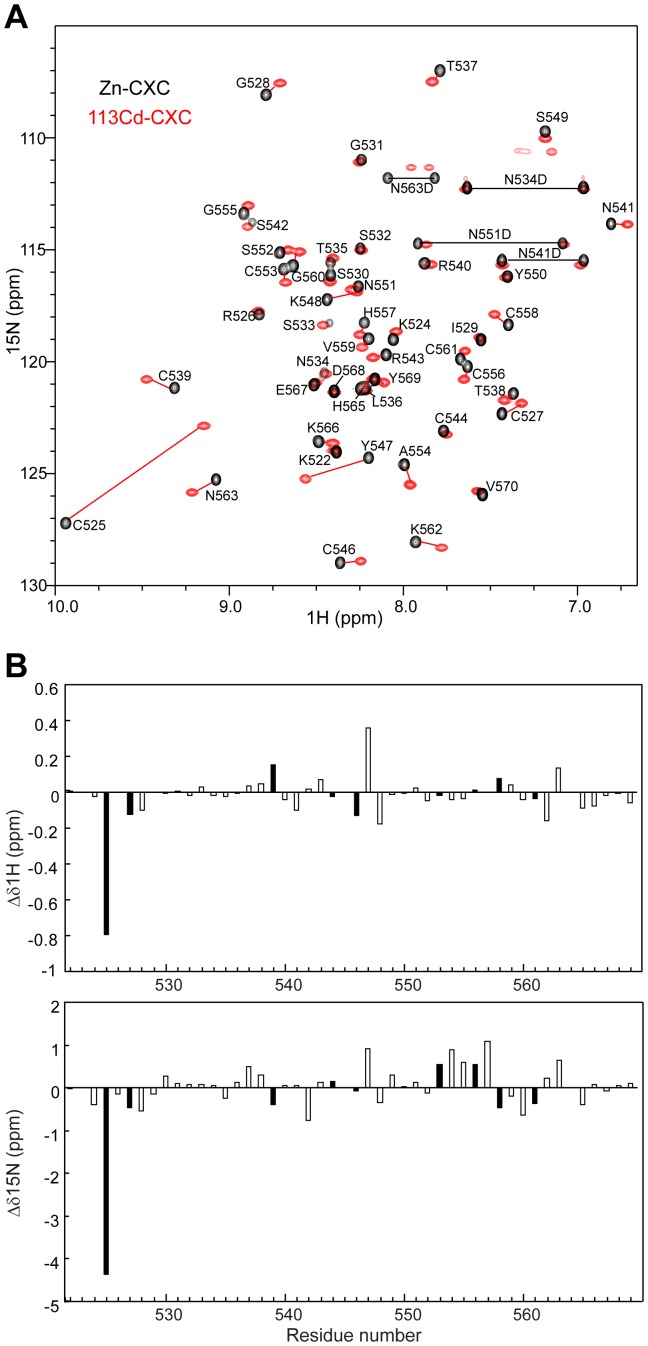
Chemical shift perturbation by 113Cd substitution.(A) Superimposed 1H-15N HSQC spectra of Zn-loaded (black) and 113Cd-loaded (red) CXC-3 proteins. Assignments are indicated for Zn-CXC. The distantly separated peak pairs are connected by red lines. The 113Cd-CXC assignments were confirmed with 3D 1H-15N TOCSY-HSQC and 3D 1H-15N NOESY-HSQC spectra collected on 113Cd/15N-labeled protein. (B) Chemical shift changes of the amide protons and nitrogens between 113Cd- and Zn-loaded CXC-3 proteins. Cys and non-Cys residues are shown with filled and empty bars. Δδ1H = δ1HCd-CXC-δ1HZn-CXC, Δδ15N = δ15NCd-CXC-δ15NZn-CXC.